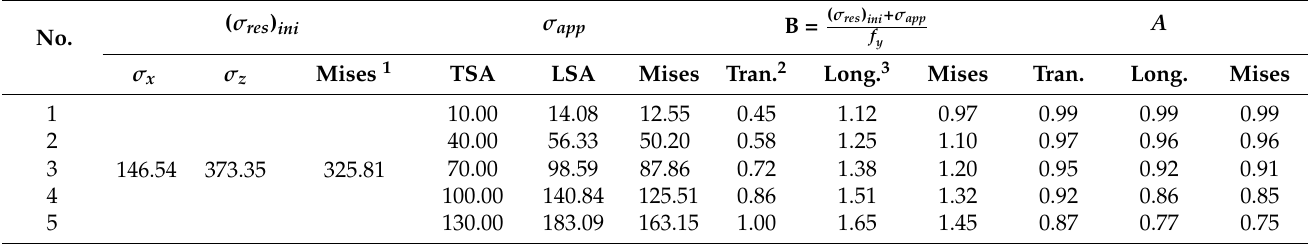
Table 2. Transverse, longitudinal, and Mises stresses under different stress amplitudes for R = 0.5 (unit: MPa). No.